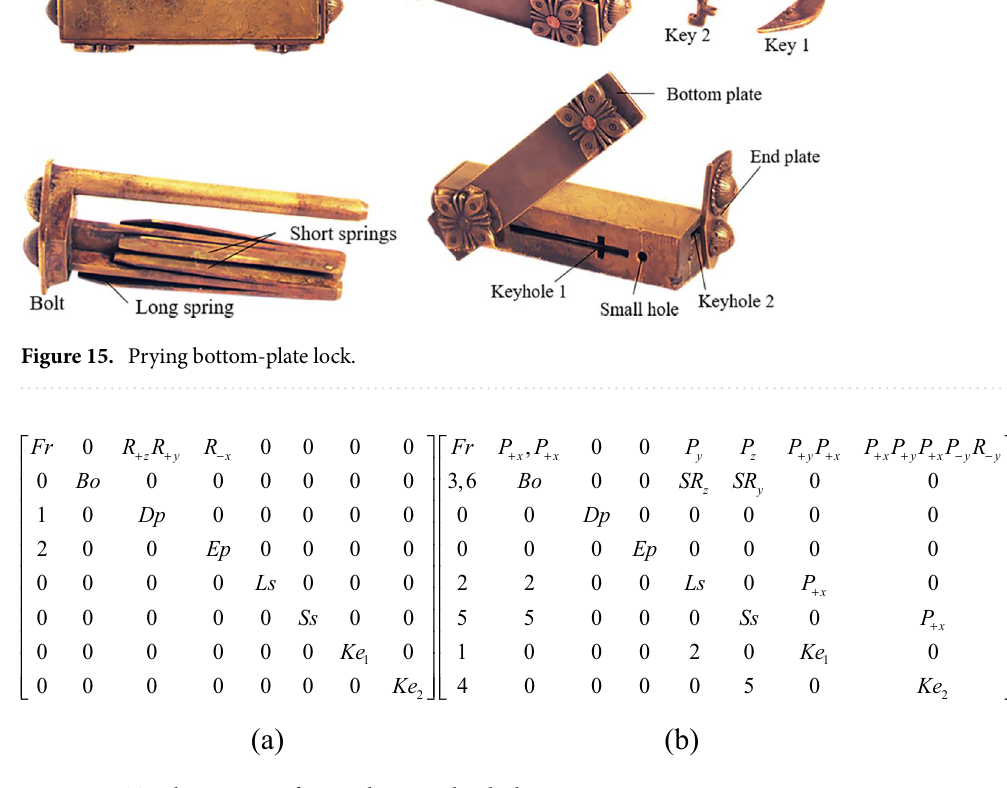
Figure 16. Topology matrix of prying bottom-plate